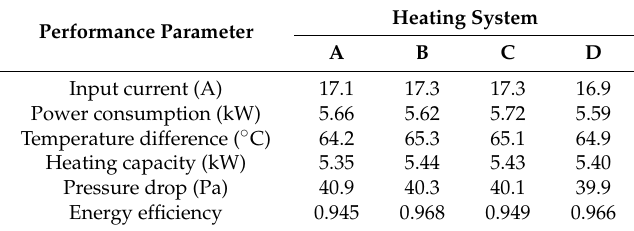
Table 9. Experimental results of heating performance.